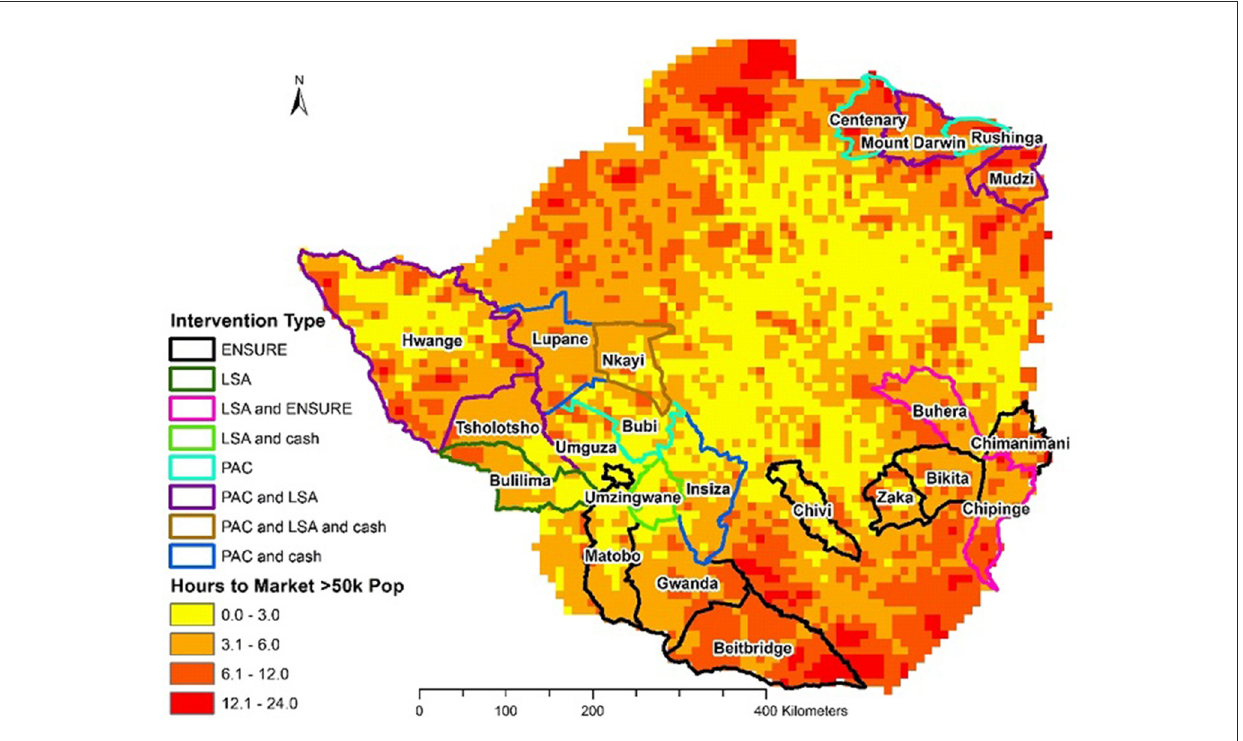
FIGURE3 WVZ interventions across market